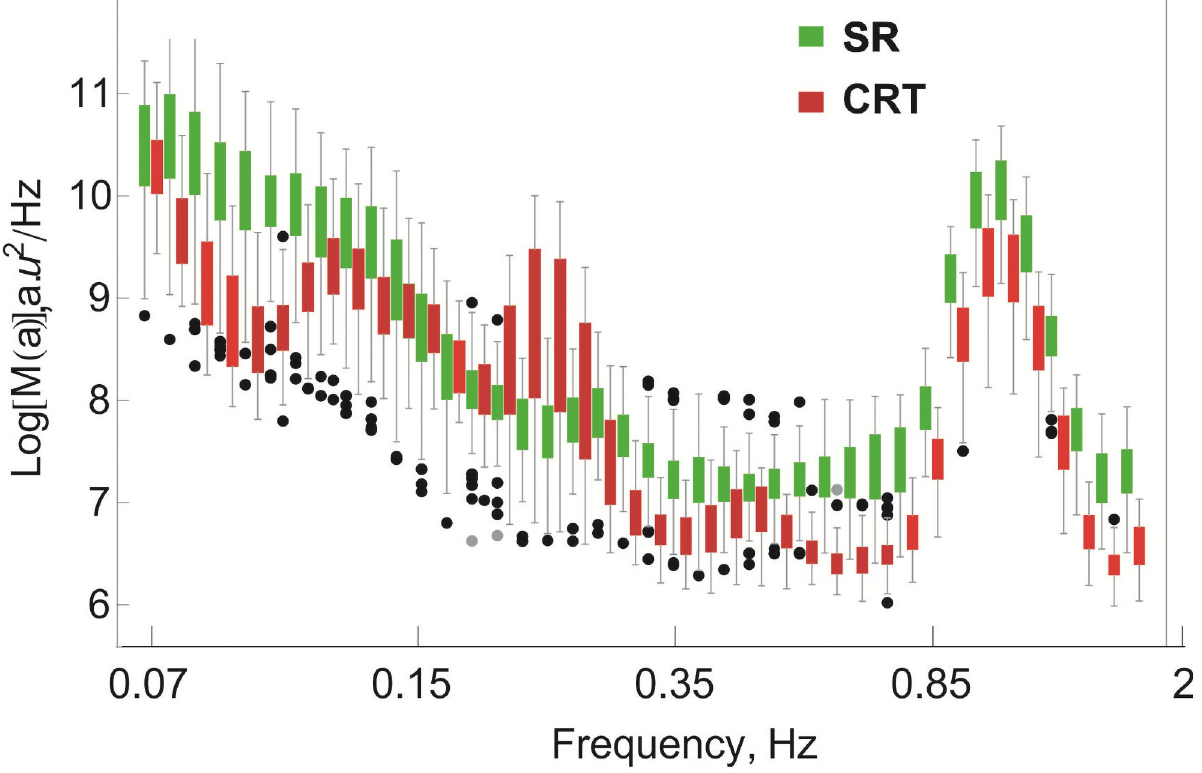
Fig 3. Wavelet spectra averaged over different roi , green colour indicate data obtained during SR, red—CRT. Dots indicate outliers.